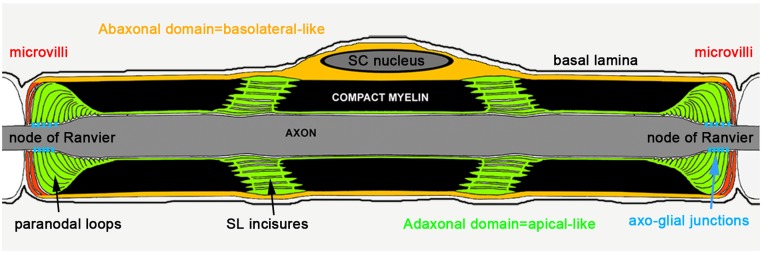
Epithelial-like polarization of the myelinating Schwann cell (Ozçelik et al., 2010).